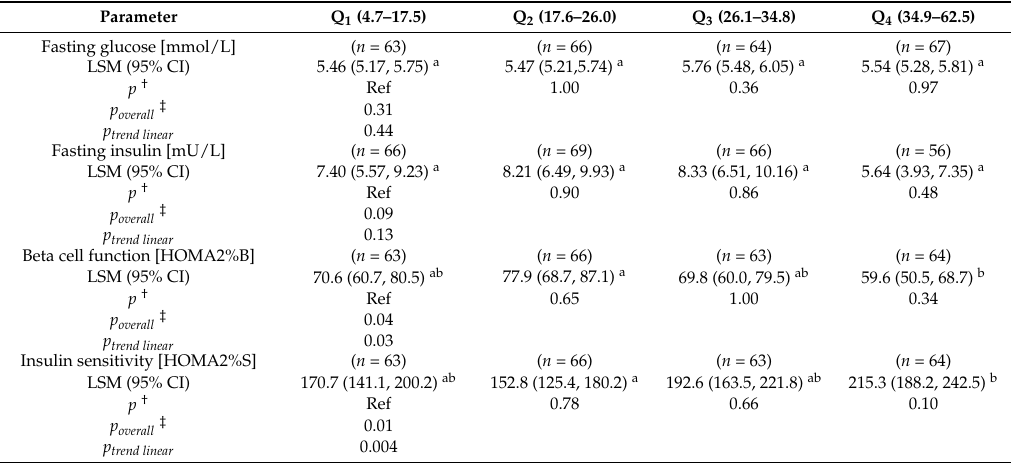
Figure 1. Fat mass index by serum 25(OH)D quartiles ( n = 271), 1 ng/mL 25-hydroxyvitamin D being equivalent to 0.4 nmol/L. Bars represent least-square means (with whisker for standard error) from multivariable linear regression models. Models were adjusted for age, sex, MVPA, smoking status (non, past, and current smoker) and LMI. 25(OH)D, 25-hydroxyvitamin D; LMI, lean mass index; MVPA, moderate to vigorous physical activity (min/day). Table 3. Parameters of glucose metabolism by 25-hydroxyvitamin D [ng/mL] quartiles (Q 1 –Q 4 ) for total